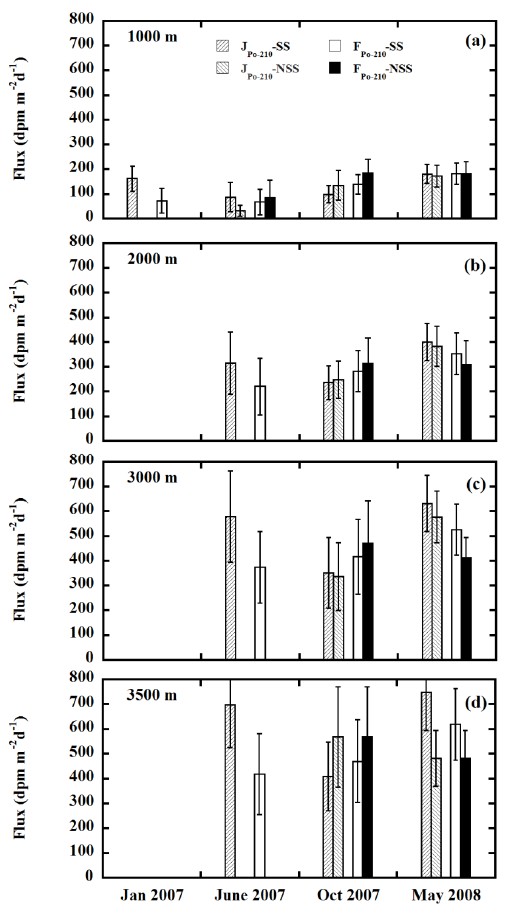
Figure 8. Scavenging ( J Po − 210 ) and removal ( F Po − 210 ) fluxes of 210 Po calculated by steady-state (SS) and non-steady-state (NSS) models at (a) 1000m, (b) 2000m, (c) 3000m, and (d)